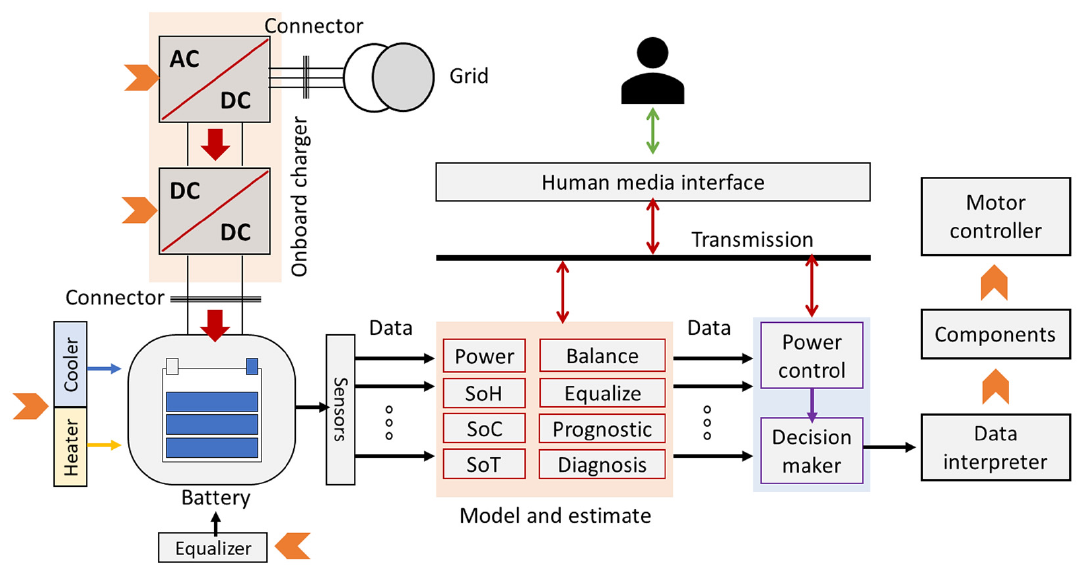
Figure 10. Conceptual illustration of battery management and power control unit.